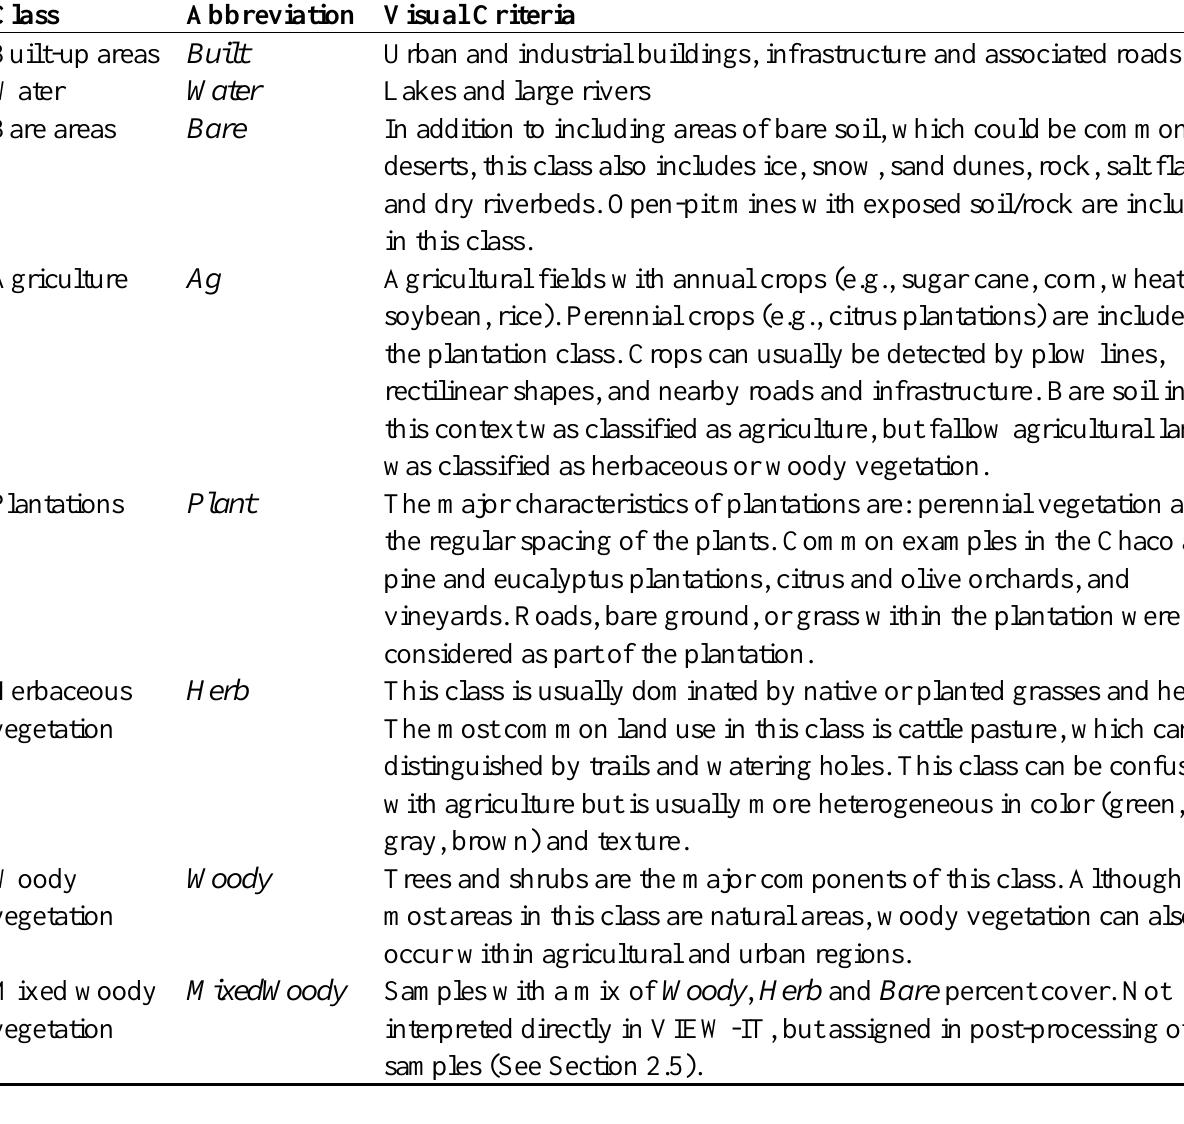
Table 1. Visual criteria used for estimating percent cover of land-use/land-cover classes in Virtual Interpretation of Earth Web-Interface Tool (VIEW-IT) (Section